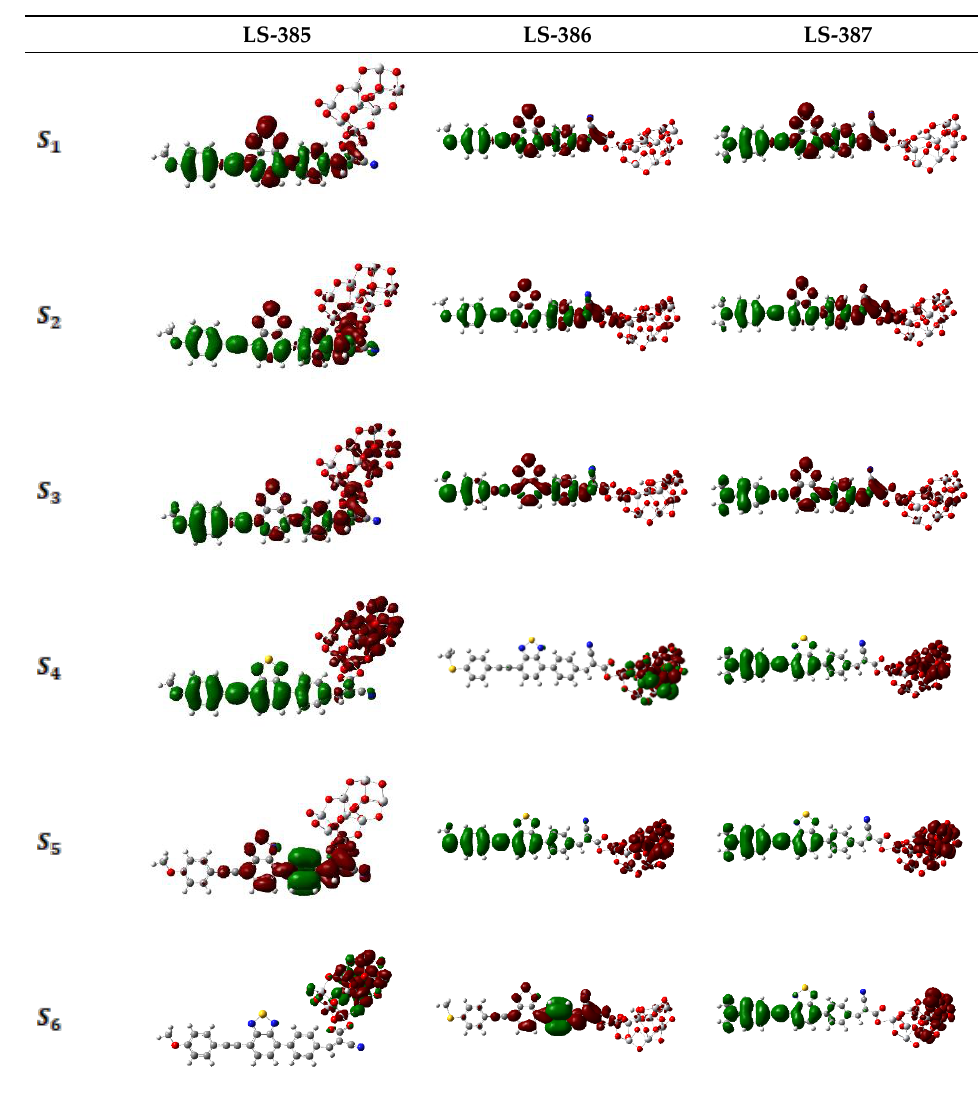
Figure 4. Charge difference density (CDD) of the selected excited state for dyes/ (TiO 2 ) 9 complexes in solvent. (Green and red stand for the hole and electron, respectively).